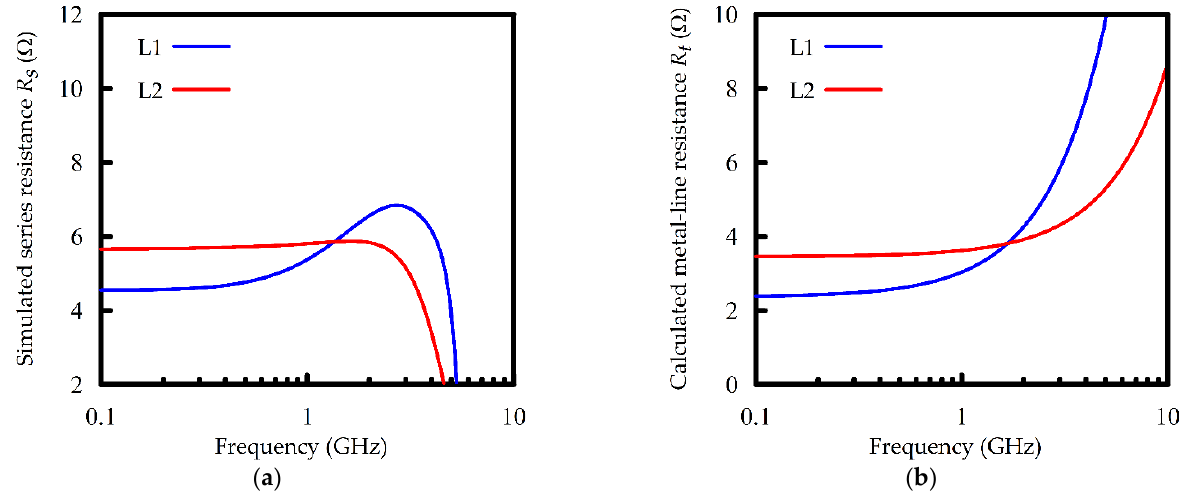
Figure 2. The frequency responses of the resistances of inductors L1 and L2. ( a ) The simulated series resistances R s ; ( b ) the calculated metal-line resistance R t .